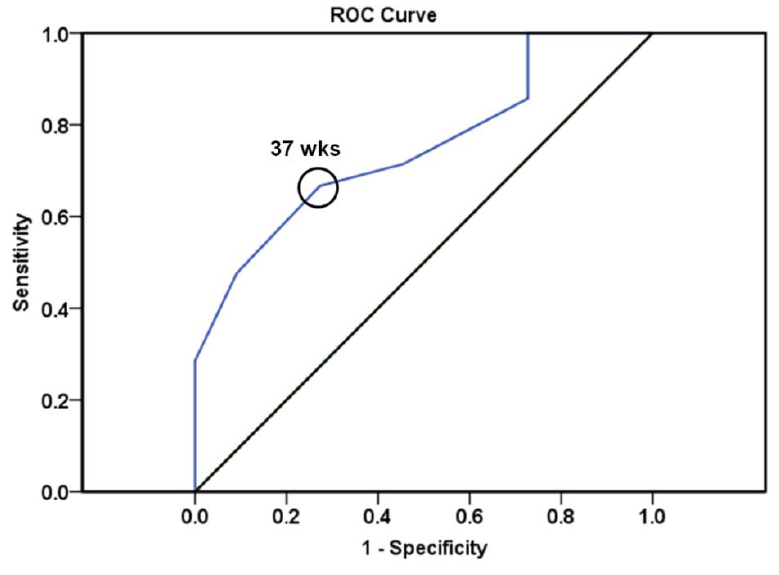
Figure 3. Receiver-operating characteristic (ROC) curve for predicting the delivery weeks for the group with higher SPR relative intensity. The optimum cut-off point (open circle) was defined as the closest point on the ROC curve to the point ( x , y ) = (0, 1), where x = 1 − specificity and y =